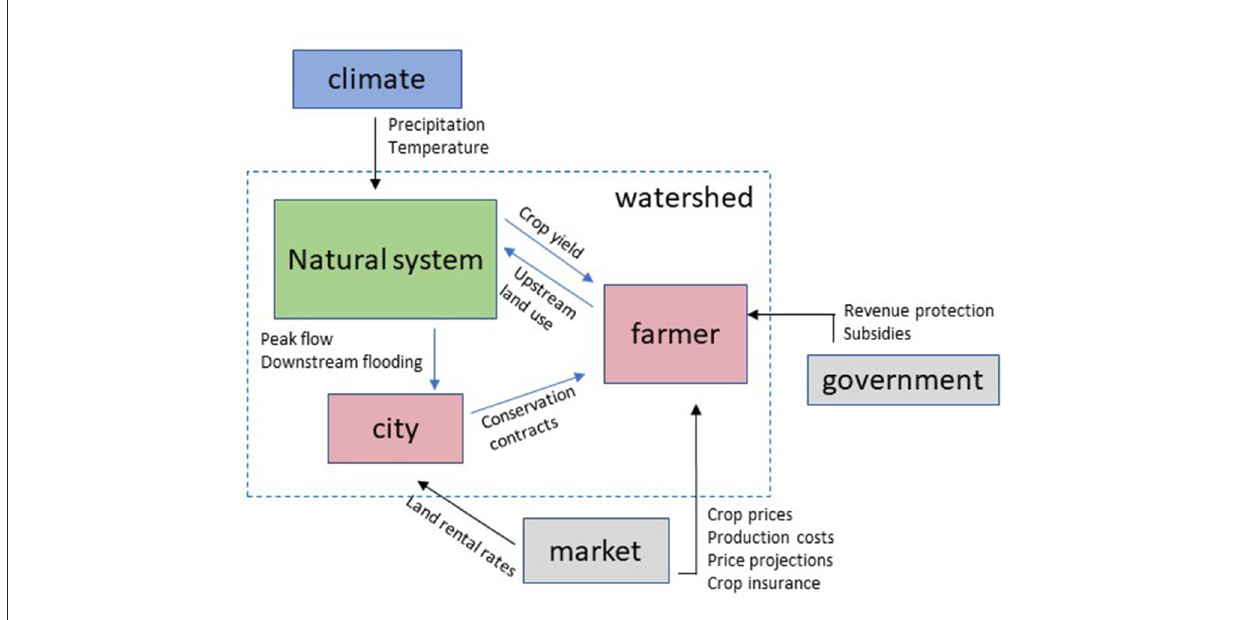
FIGURE1 Flowchart of the socio-hydrologic